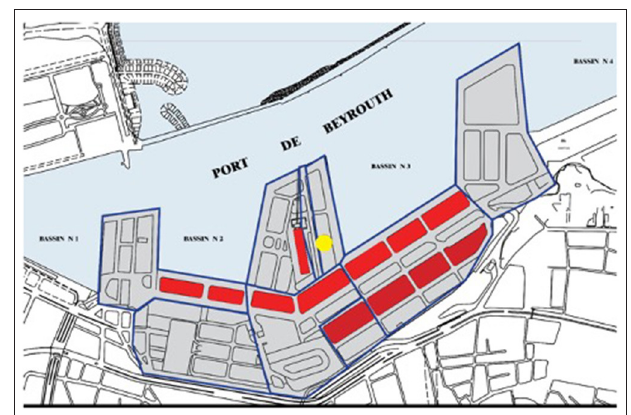
FIGURE 1 | Blast location at the port of Beirut and adjacent warehouses. The yellow circle refers to the blast location in hangar 12 next to the grain silos and fireworks warehouses. Red rectangles depict the